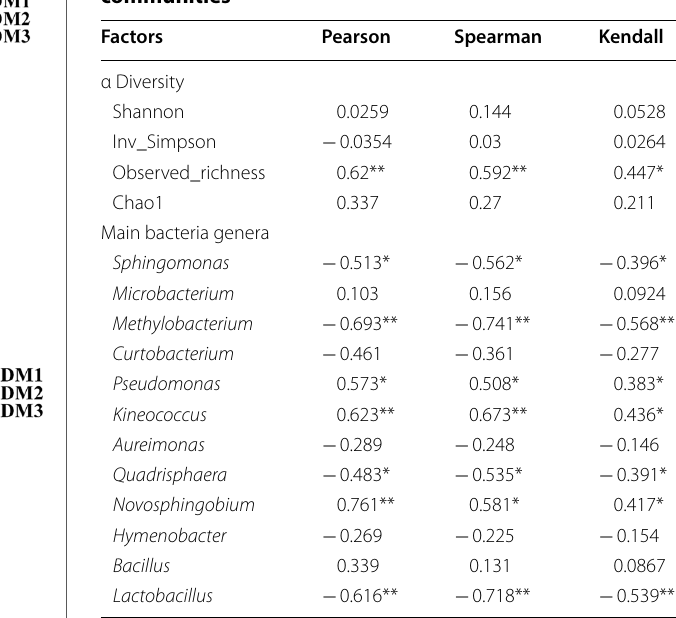
Table 1 Correlation analysis between lesion coverage rate (LCR) and α diversities index and main genera of bacterial